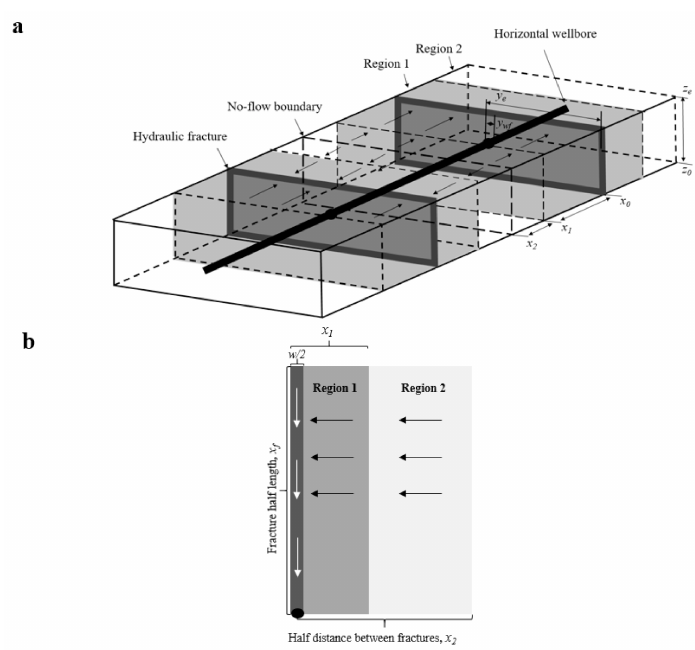
Figure 1. Schematic of a multistage fractured horizontal well with two regions around the hydraulic fracture. ( a ) The 3D model. ( b ) The plan